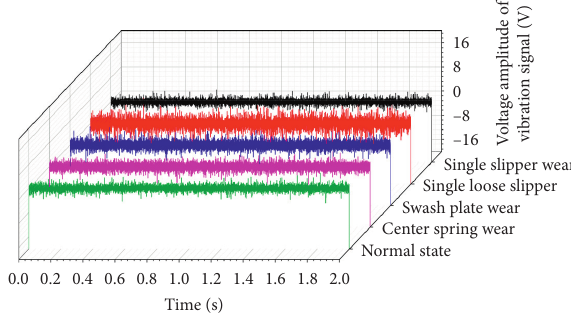
Figure 10: The time-domain waveform of vibration signal in (z)